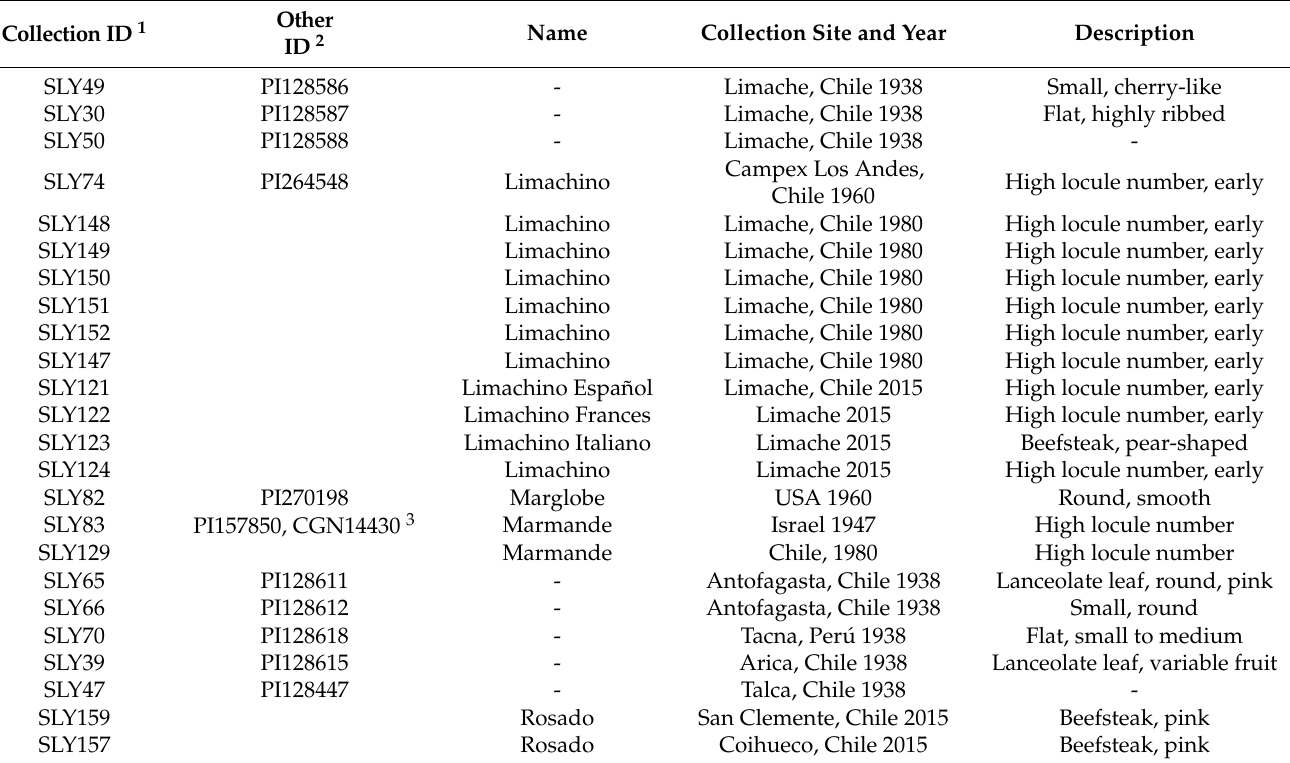
Table 1. Information on the tomato landraces used in this